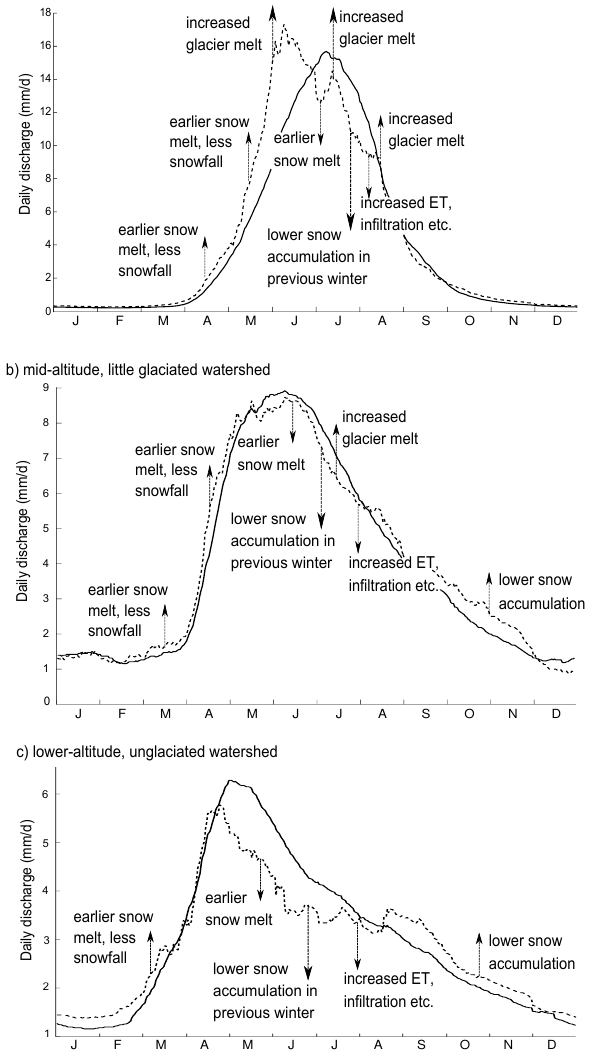
Figure 8. Long-term annual streamflow cycle (1980–2010) of (a) a higher-altitude watershed (Gepatschalm, 2880m, 39.3% glaciated), (b) a mid-altitude, little glaciated watershed (See i. P., 2303m, 1.6% glaciated.) and (c) a lower-altitude, unglaciated watershed (Ehrwald, 1467m), trends generated from the end point of Sen’s slope estimator (dashed line, similar to Déry et al., 2009) and poten- tial causes. Long arrows correspond to strong drivers, short arrows to weaker